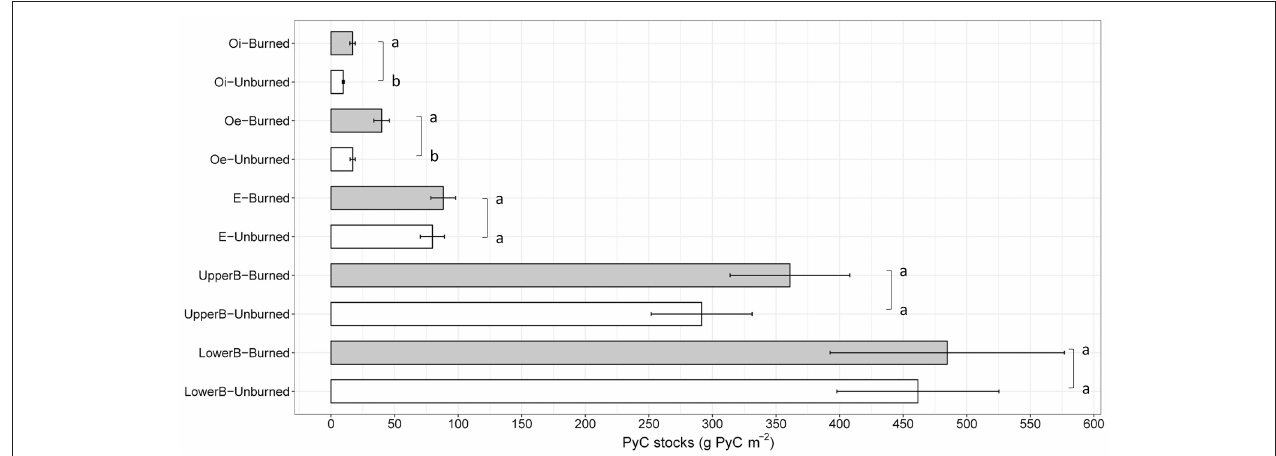
FIGURE 2 | Pyrogenic carbon (PyC) stocks (g m − 2 ) in organic (Oi and Oe) and mineral horizons E and B in burned and unburned sites, determined by the KMD method. Values shown are means ± standard error. Similar letters denote no statistically significant differences ( P < 0.05). Number of replicates: Oi-Burned and -Unburned ( n = 9), Oe-Burned and -Unburned ( n = 8), E-Burned ( n = 8), and -Unburned ( n = 9), UpperB-Burned and -Unburned ( n = 9), and LowerB-Burned and -Unburned ( n = 9).